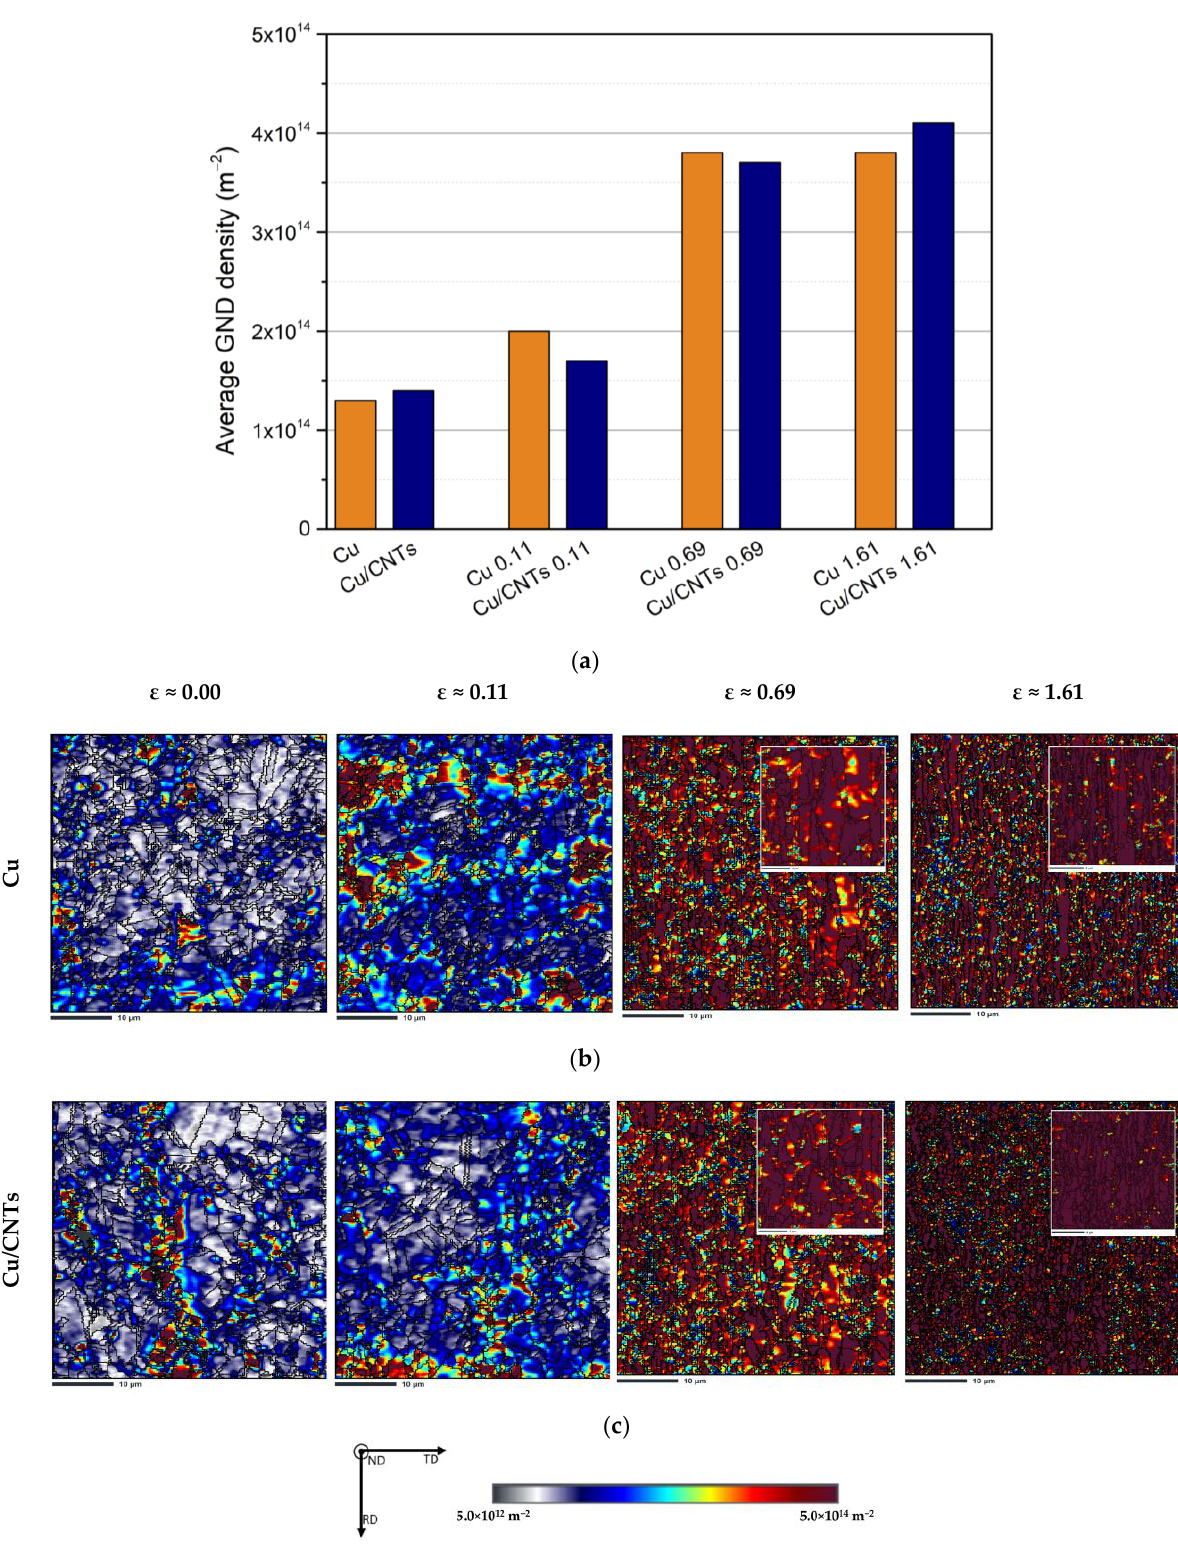
Figure 14. ( a ) Estimated GND density and ( b , c ) GND maps of the Cu and Cu/CNT samples, as- sintered and cold rolled to strains up to 0.11, 0.69, and 1.61, respectively. A higher magnification detailed is present for the higher strains.